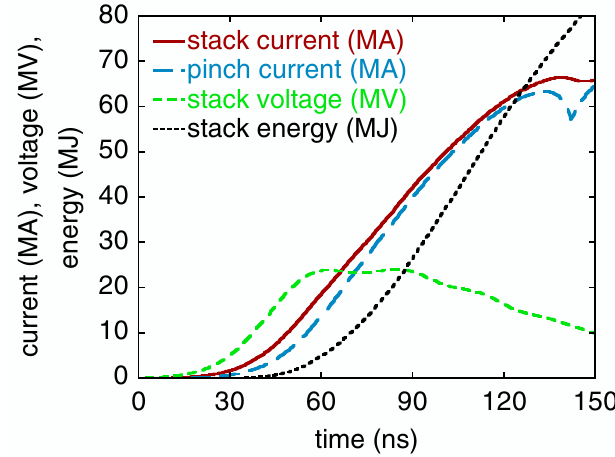
FIG. 6. (Color) The stack current, pinch current, stack voltage, and stack energy for the LTD-based accelerator referred to as option 1 in Table